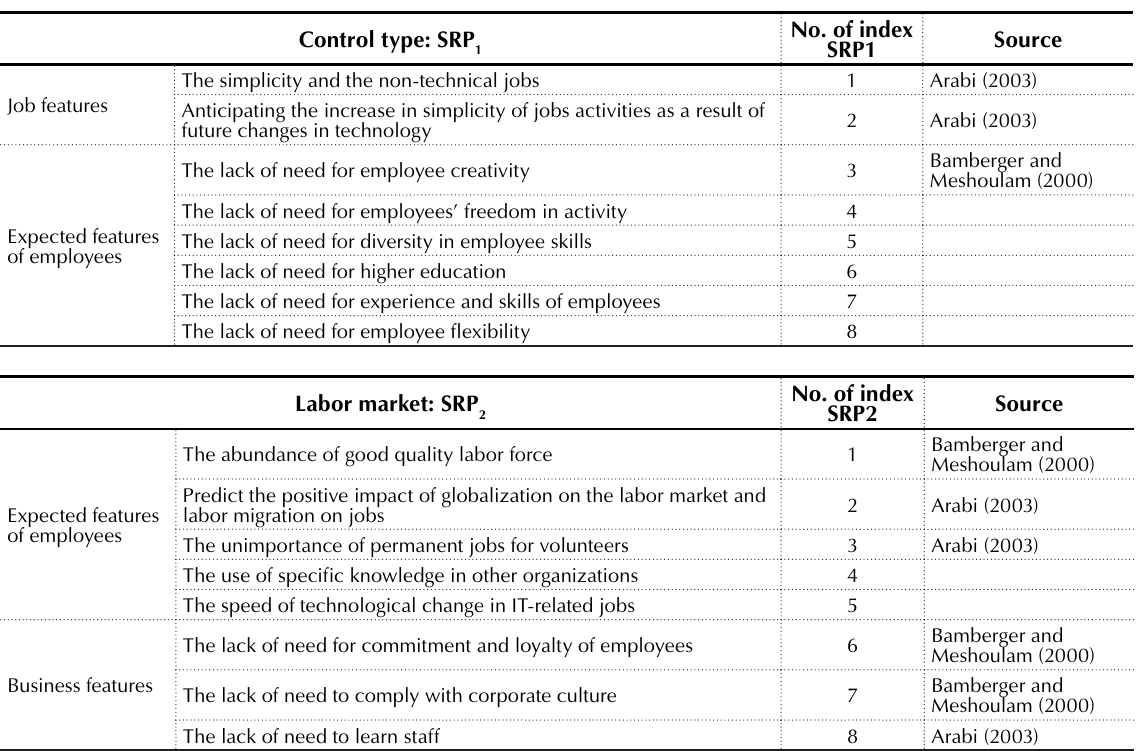
Table 2. Secondary SRPs (indices) separated by the job characteristics and features expected of